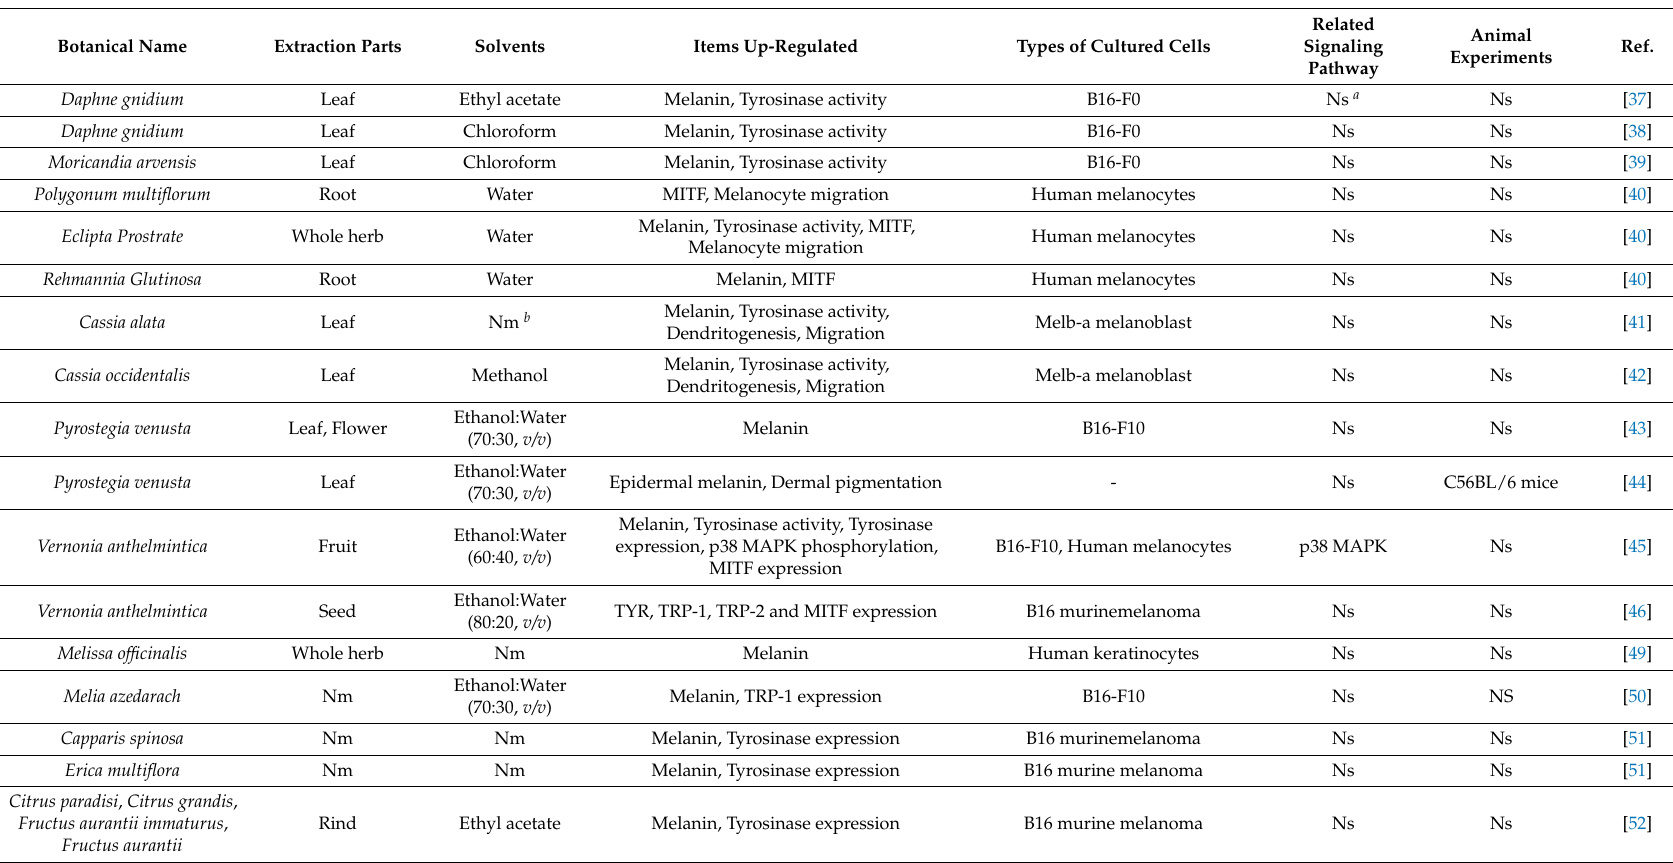
Table 1. Summary of stimulation effect on tyrosinase, melanogenesis and other factors in cultured cells and pigmentation responsein animal of different